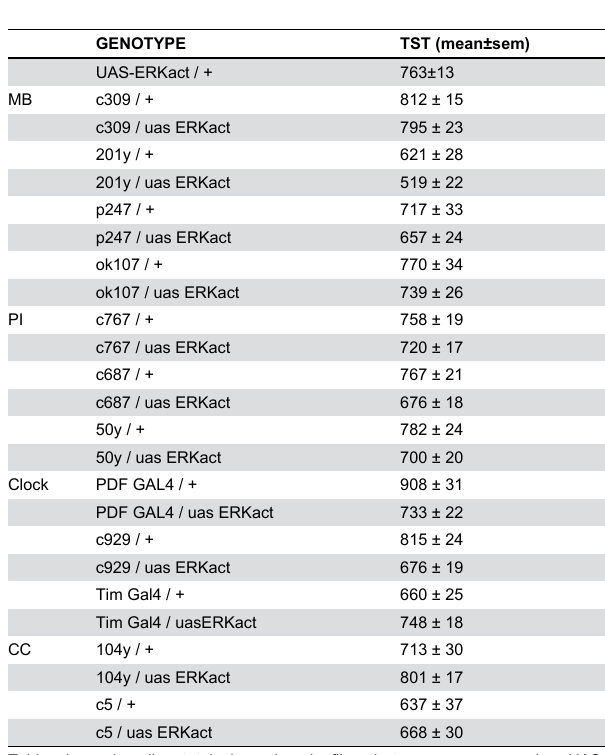
Table 1. ERK over-expression in previously determined sleep/wake circuits in Drosophila